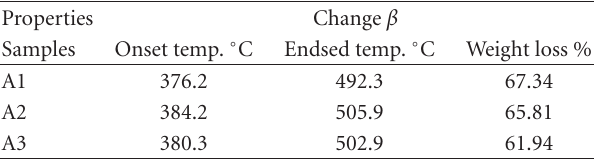
Table 3: Characterization of change β